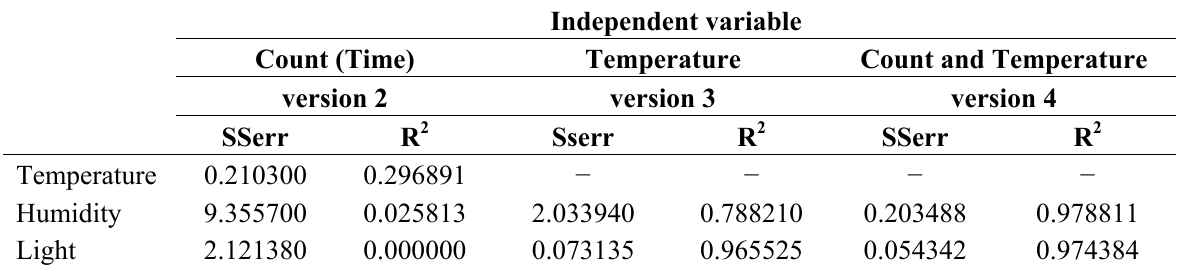
Table 6. Performance results of the SSerr and R 2 from all versions in scenarios #1, #4 and #6.